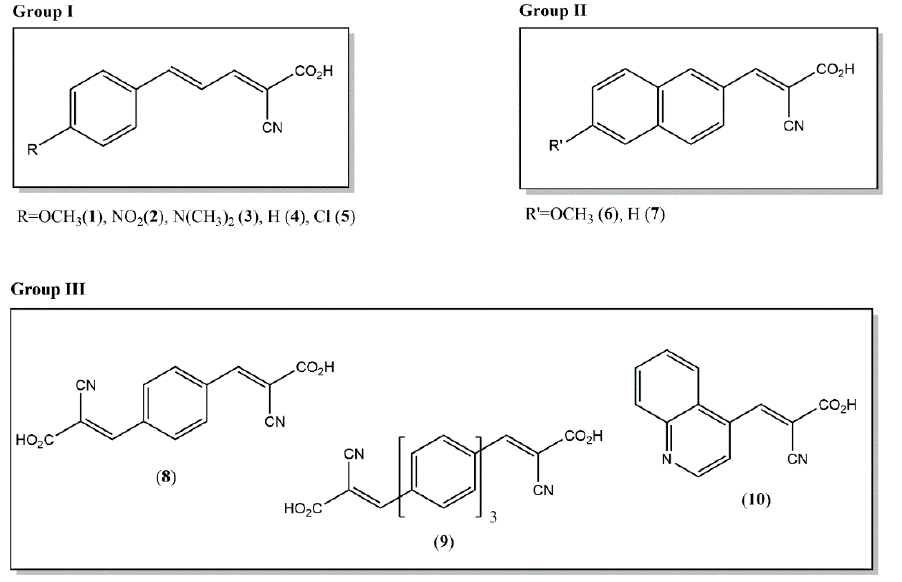
Figure 1. Chemical structures of the synthetized compounds: 2E,4E)-2-cyano-5-(4- methoxyphenyl)penta-2,4-dienoic acid ( 1 ); (2E,4E)-2-cyano-5-(4-nitrophenyl)penta-2,4-dienoic acid ( 2 ); (2E,4E)-2-cyano-5-(4-(dimethylamino)phenyl)penta-2,4-dienoic acid ( 3 ); (2E,4E)-2-cyano-5- phenylpenta-2,4-dienoic acid ( 4 ); (2E,4E)-5-(4-chlorophenyl)-2-cyanopenta-2,4-dienoic acid ( 5 ); (E)- 2-cyano-3-(6-methoxynaphthalen-2-yl)acrylic acid ( 6 ); (E)-2-cyano-3-(naphthalen-2-yl)acrylic acid ( 7 ); (2E,2’E)-3,3’-(1,4-phenylene)bis(2-cyanoacrylic acid) ( 8 ); (2E,2’E)-3,3’-([1,1’:4’,1’’-terphenyl]- 4,4’’-diyl)bis(2-cyanoacrylic acid) ( 9 ); (E)-2-cyano-3-(quinolin-4-yl)acrylic acid ( 10 ).